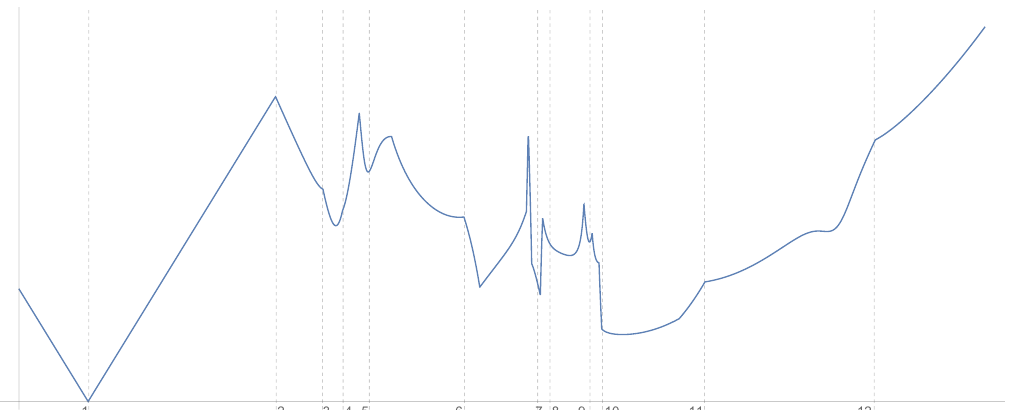
Figure 12. The magnitude of the deformation vector ~(cid:20) along a line segment (see (cid:12)gure 11): at annotated point 1, the line crosses a focal point, which forces the deformation to zero. Features 2 to 12 are crossings with the line and the points, where either the real or the imaginary part of the deformed E-surface equations vanishes. These intersections cause a non-smooth behaviour of the deformation vector (cid:12)eld ~(cid:20) due to the constraints on the magnitude.